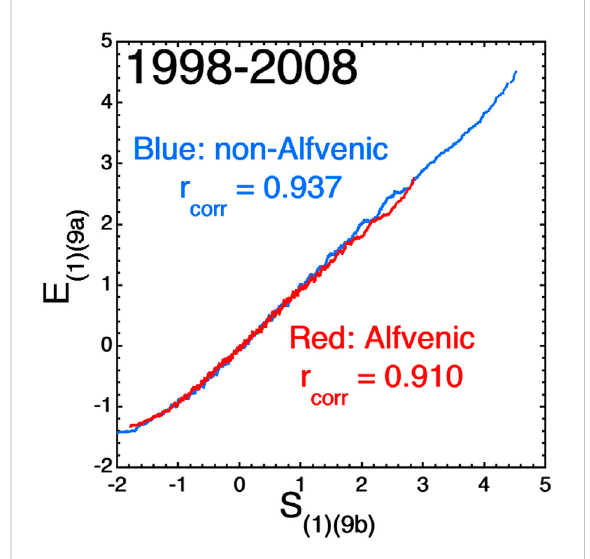
FIGURE 8 201-point running averages of the Earth index E (1)(9a) are plotted as functions of the solar-wind composite driver S (1)(9b) separately for times whe n the solar wind was non-Alfvénic (blue, | A| < 0.75)andfortimeswhenthesolarwindwasAlfvénic(red, |A| > 0.75).